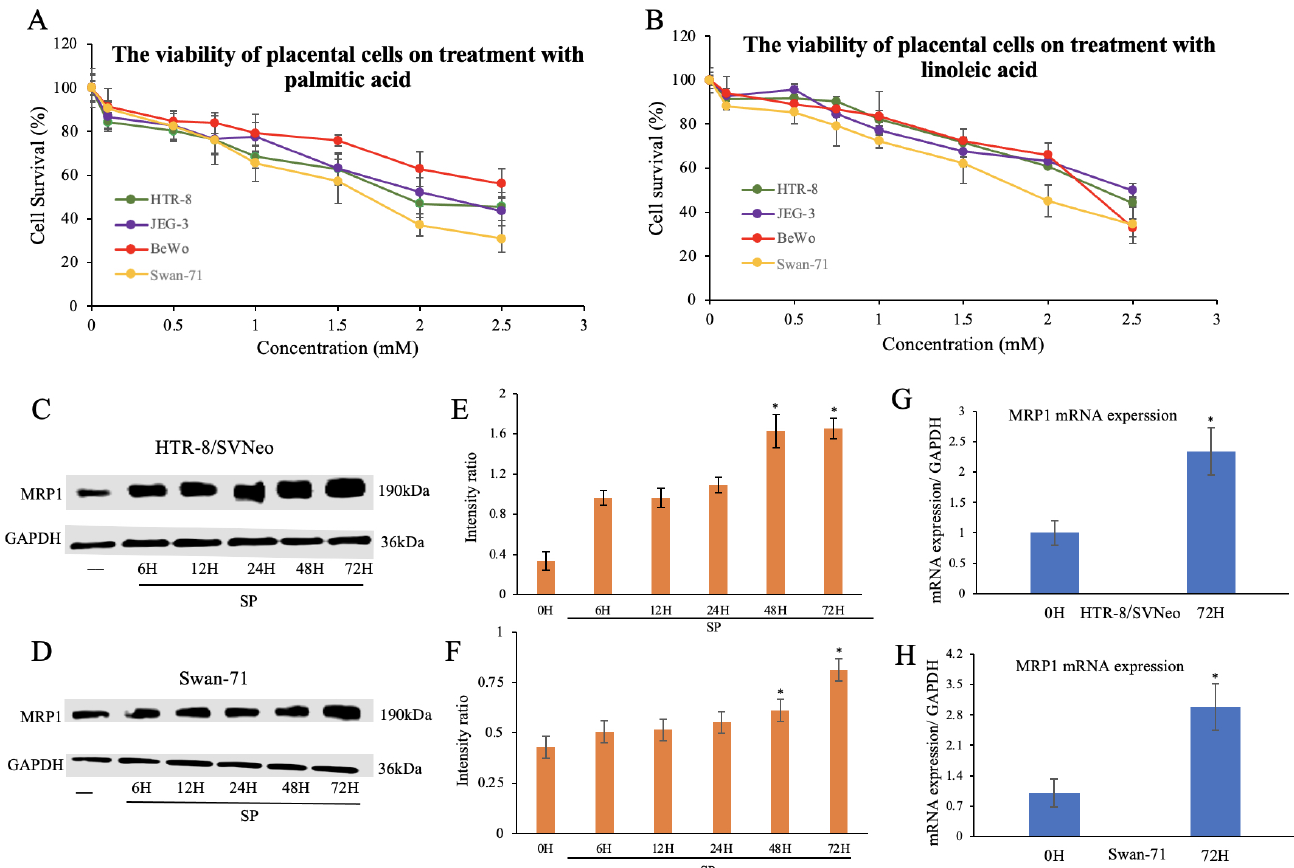
Figure 1. Effect of palmitic and linoleic acids on cytotoxicity, MRP1 protein levels, and ABCC1 gene expression in placental cell lines. Cell viability vs. concentration curves of HTR-8/SVneo, JEG-3, BeWo, and Swan-71 cells upon treatment with palmitic ( A ) and linoleic acid ( B ), determined by efflux assay. Effect of 0.5 mM palmitic acid on MRP1 protein expression in HTR8/SVneo ( C ) and Swan-71 cells ( D ) determined by Western blotting. Grayscale ratios were calculated with the help of ImageJ ( E , F ). ABCC1 mRNA expression upon treatment with 0.5 mM palmitic acid in HTR8/SVneo ( G ) and Swan-71 cells ( H ) determined by RT-qPCR. Mean values were obtained from three independent experiments and error bars indicate SD. SP, sodium palmitate. * p < 0.05 compared to controls.